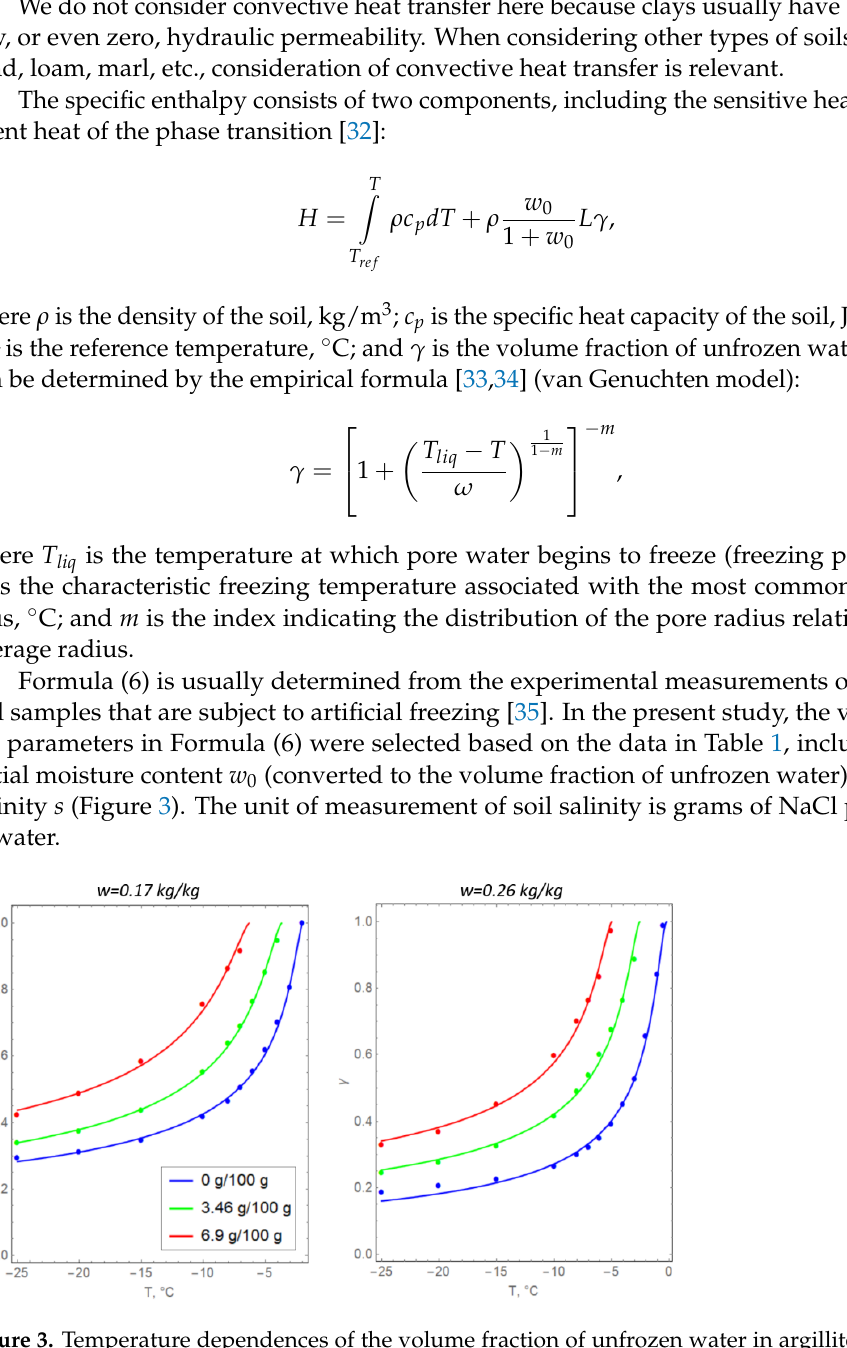
Figure 2. Considered computational domain.